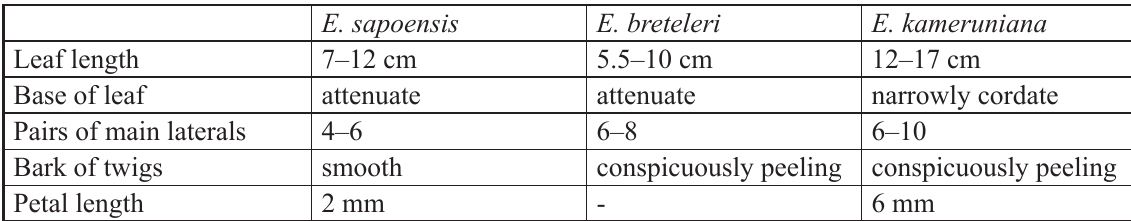
Table 1. Main differences between Eugenia sapoensis sp. nov., Eugenia breteleri sp. nov. and E.